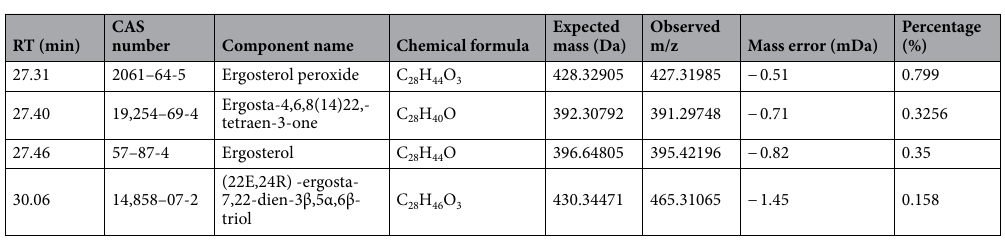
Table 1. Affiliation of key peaks of